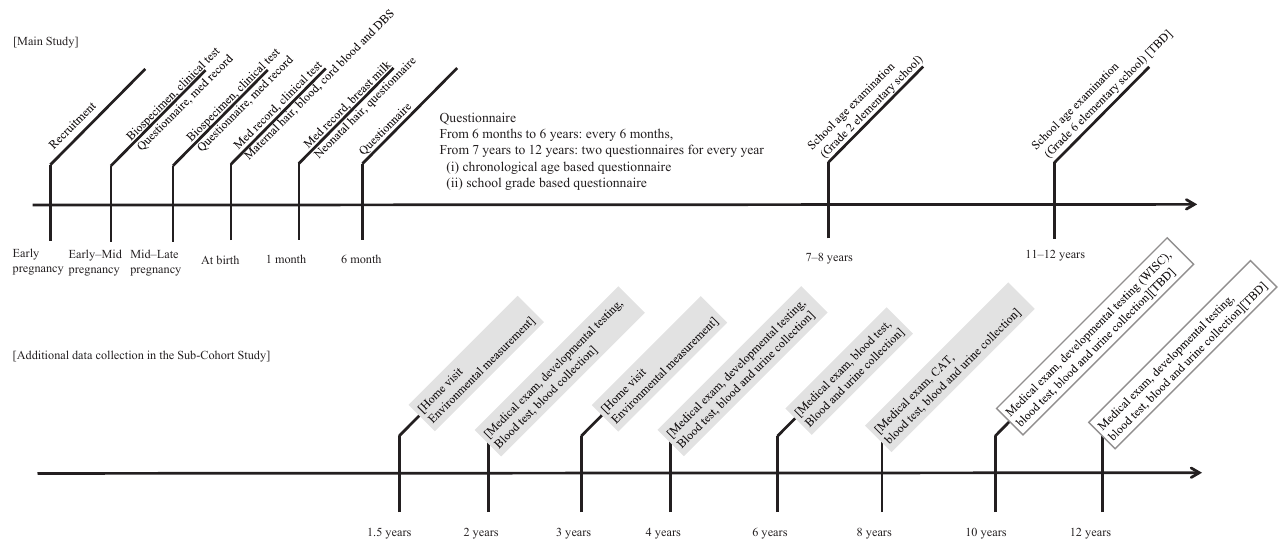
Figure 1. The JECS Sub-Cohort Study data collection timeline. DBS, dried blood spot; CAT, computer assisted tests; WISC, Wechsler Intelligence Scale for Children; TBD, to be